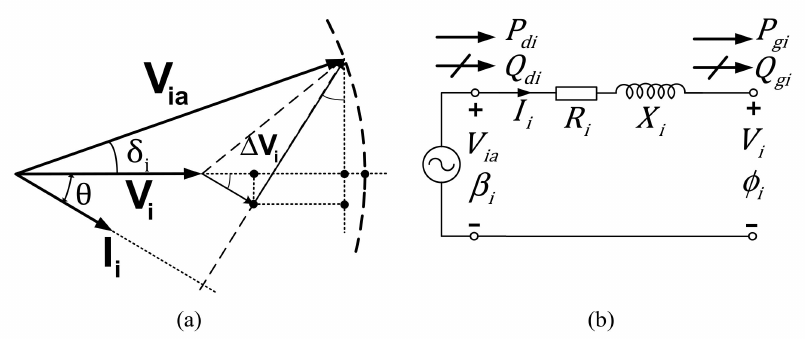
Figure 4. ( a ) Phasor representation and ( b ) equivalent circuit of the inverter-VSC operation